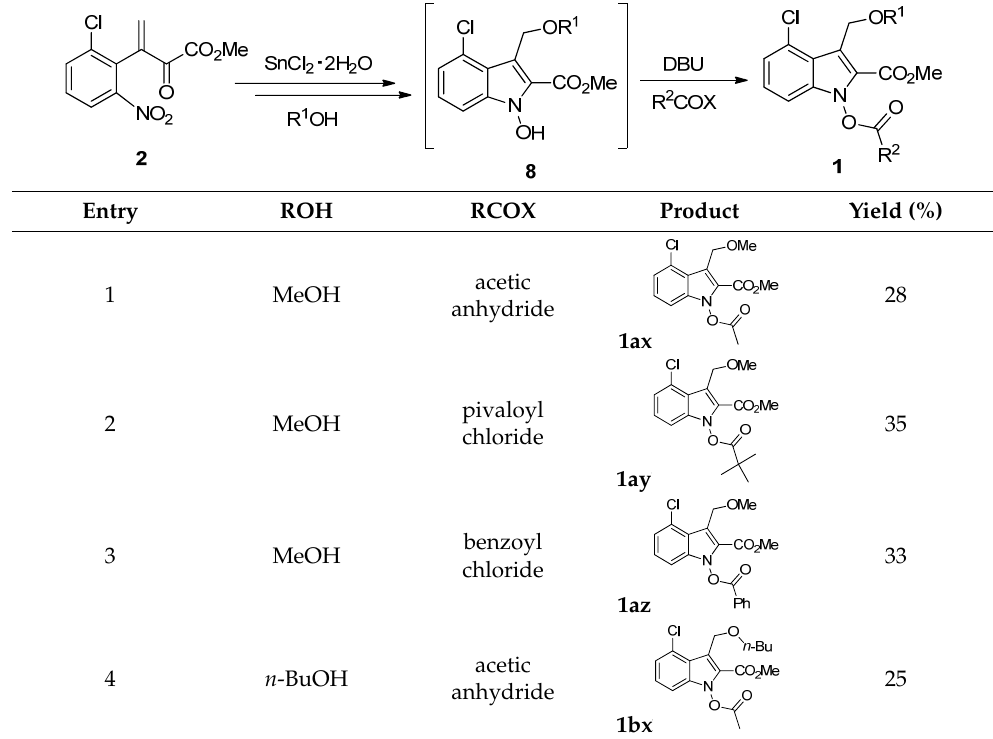
Table 2. Synthesis of derivatives of 1-acyloxyindole 1 a .